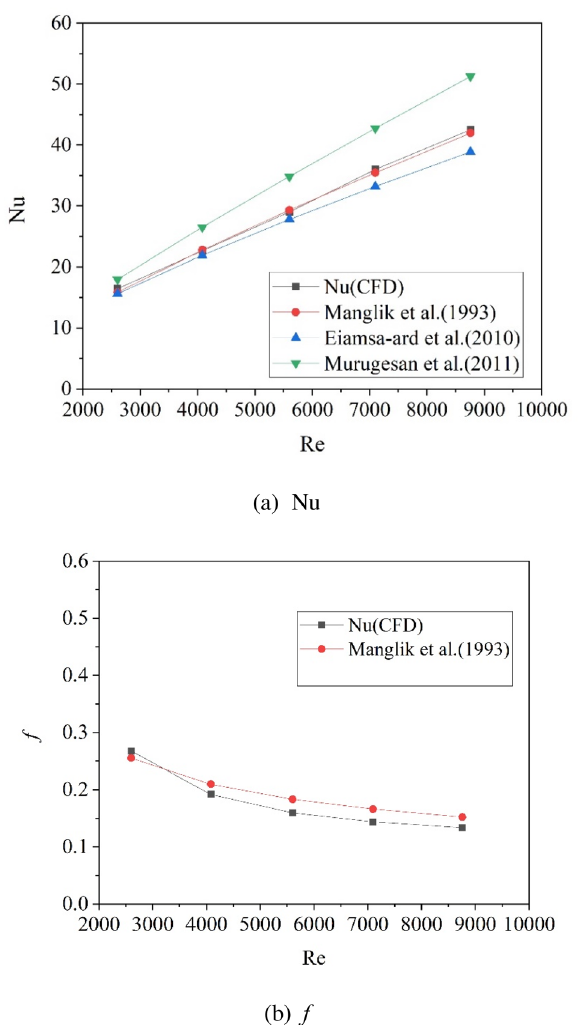
Figure 4. Comparison of the calculated Nu and f with empirical correlations for the tube with twisted